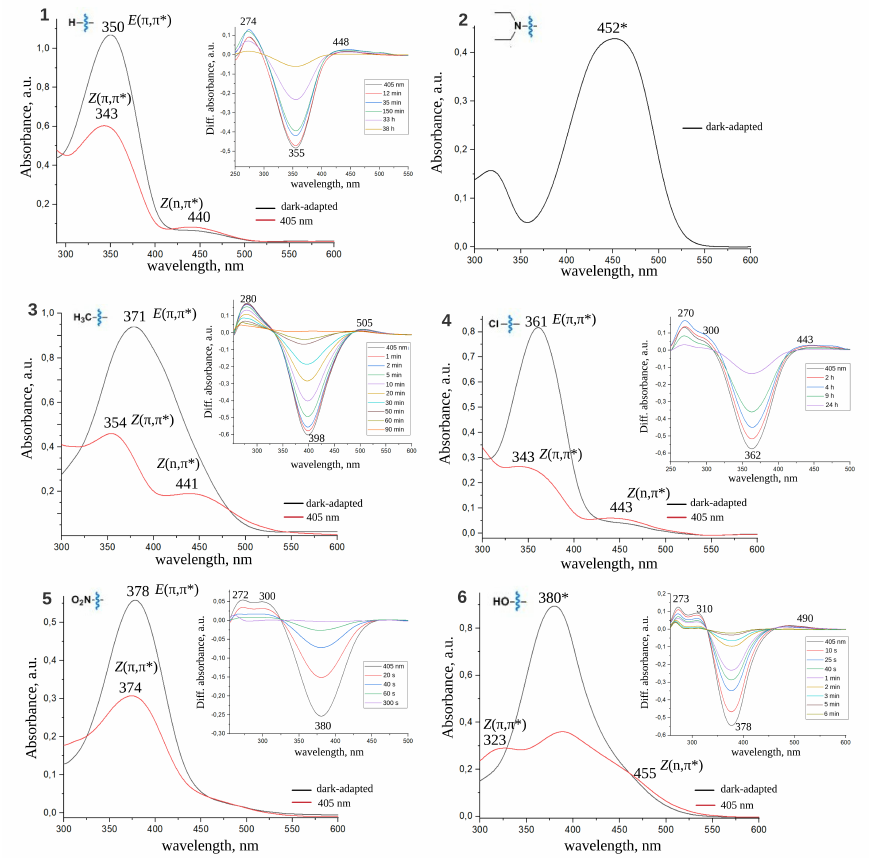
Figure 2. Dark-adapted and light-adapted spectra of investigated ATPLs in DMSO. Transient absorption UV-Vis spectra are shown in the insets. Spectral bands are related to E , Z isomers and ( π , π ∗ ), ( n , π ∗ ) transitions. * For compounds 2 and 6 the band can be decomposed into two Gaussian functions (see Supplementary Materials for